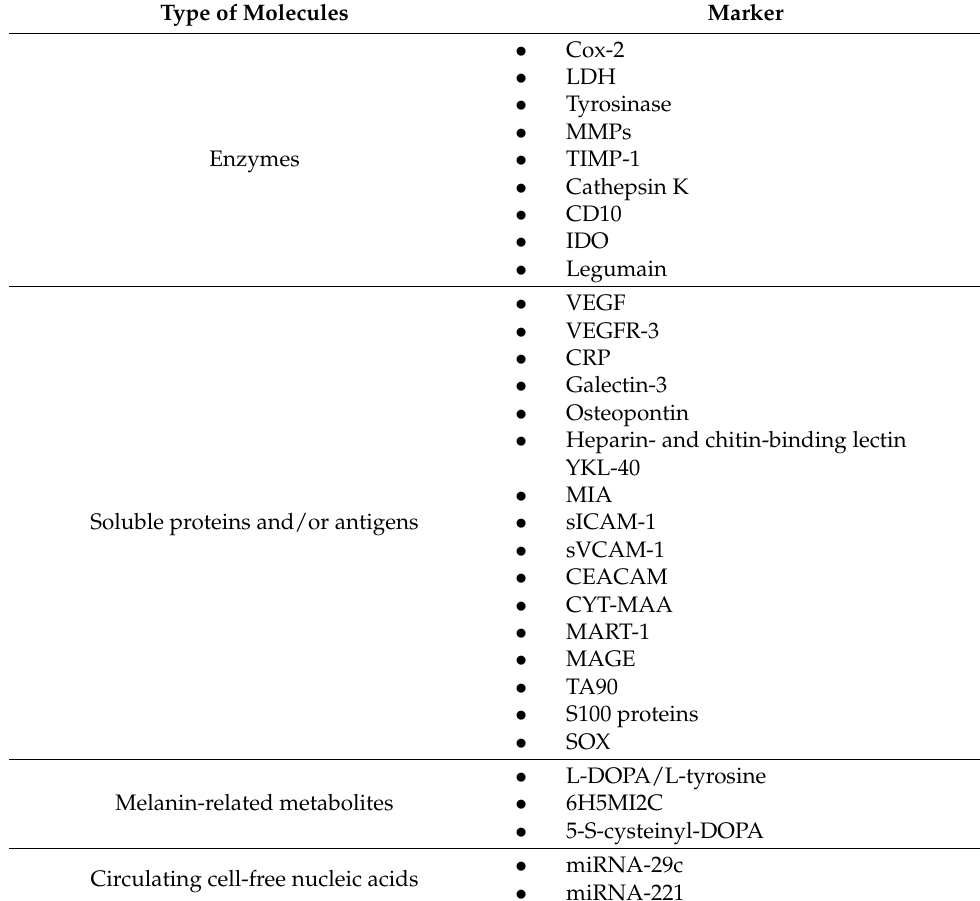
Table 4. Putative malignant melanoma